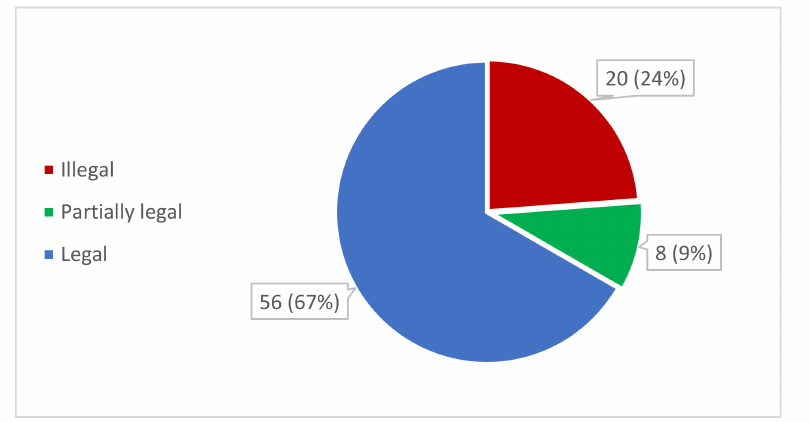
Figure 4. Ratio of jurisdictions in which Bitcoin (and other crypto coins) are permitted or forbidden to